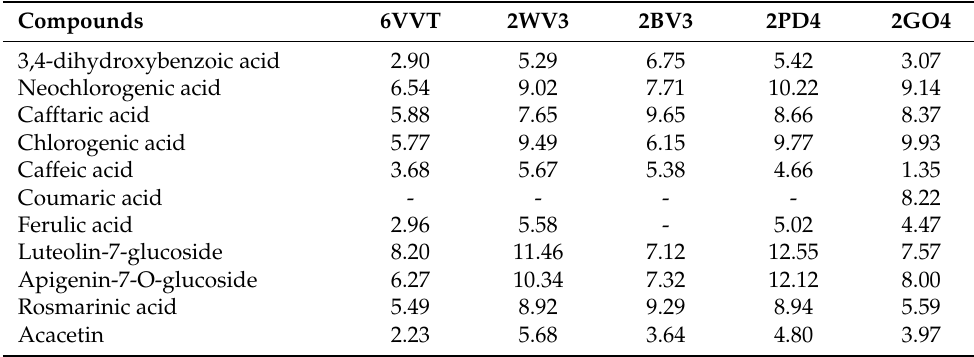
Table 3. Scoring function for corresponding enzyme and natural product. Compounds